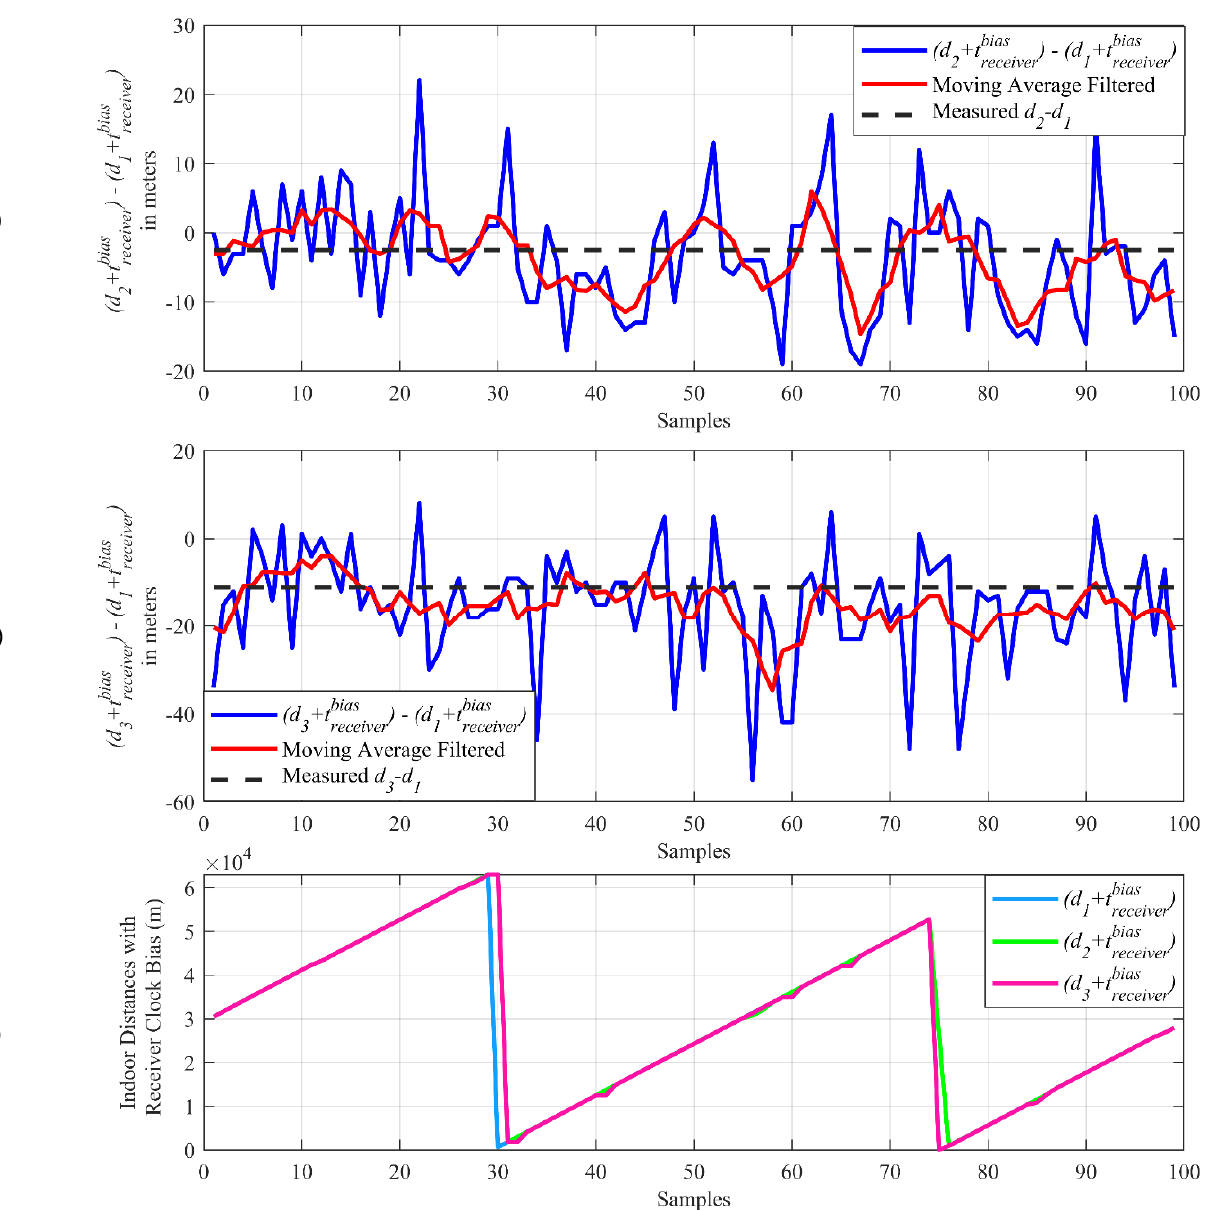
Figure 14. The indoor distance differences ( a , b ) and indoor distances with the receiver clock bias term ( c ). + t receiver , d 3 + t receiver bias